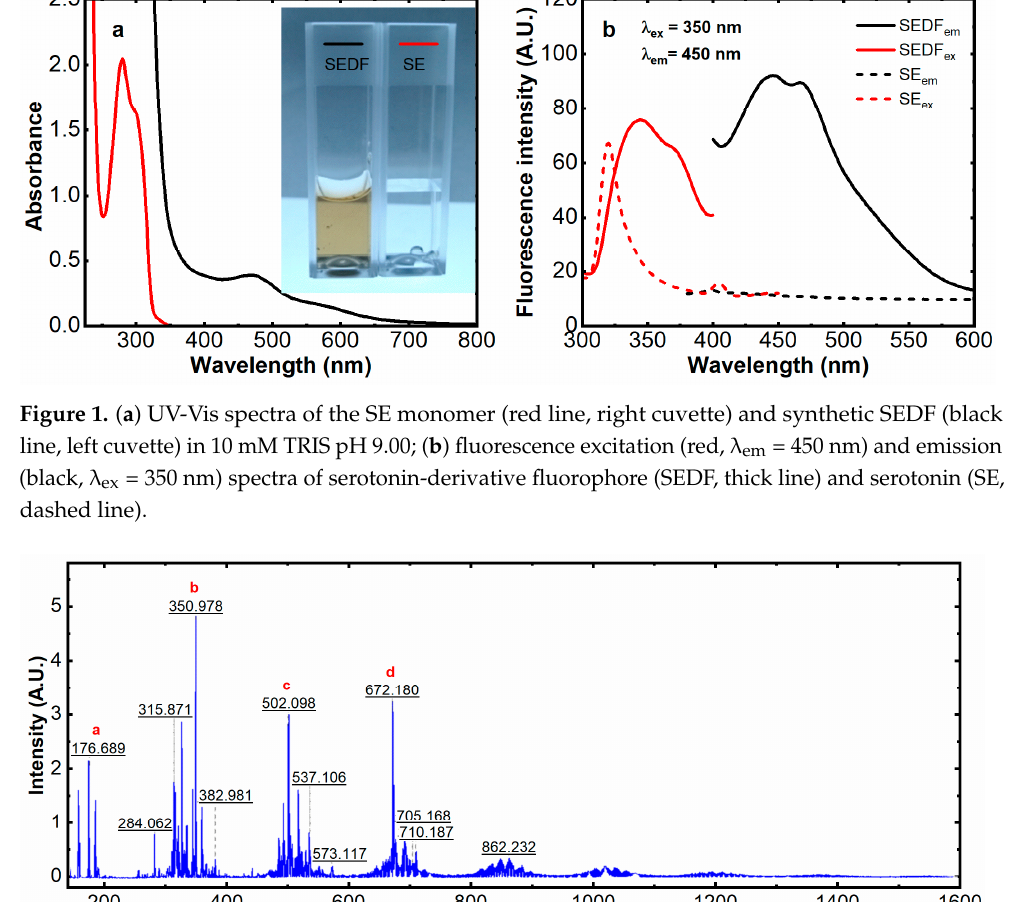
Figure 1 . ( a ) UV-Vis spectra of the SE monomer (red line, right cuvette) and synthetic SEDF (black line, left cuvette) in 10 mM TRIS pH 9.00; ( b ) fluorescence excitation (red, λ em = 450 nm) and emission (black, λ ex = 350 nm) spectra of serotonin-derivative fluorophore (SEDF, thick line) and serotonin (SE, dashed line).